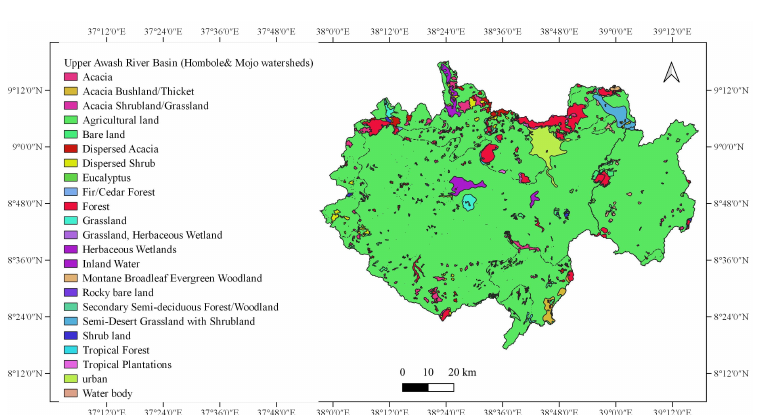
Figure A4. Land use map of Upper Awash River Basin (Hombole and Mojo watersheds) from 1989 to 2000.